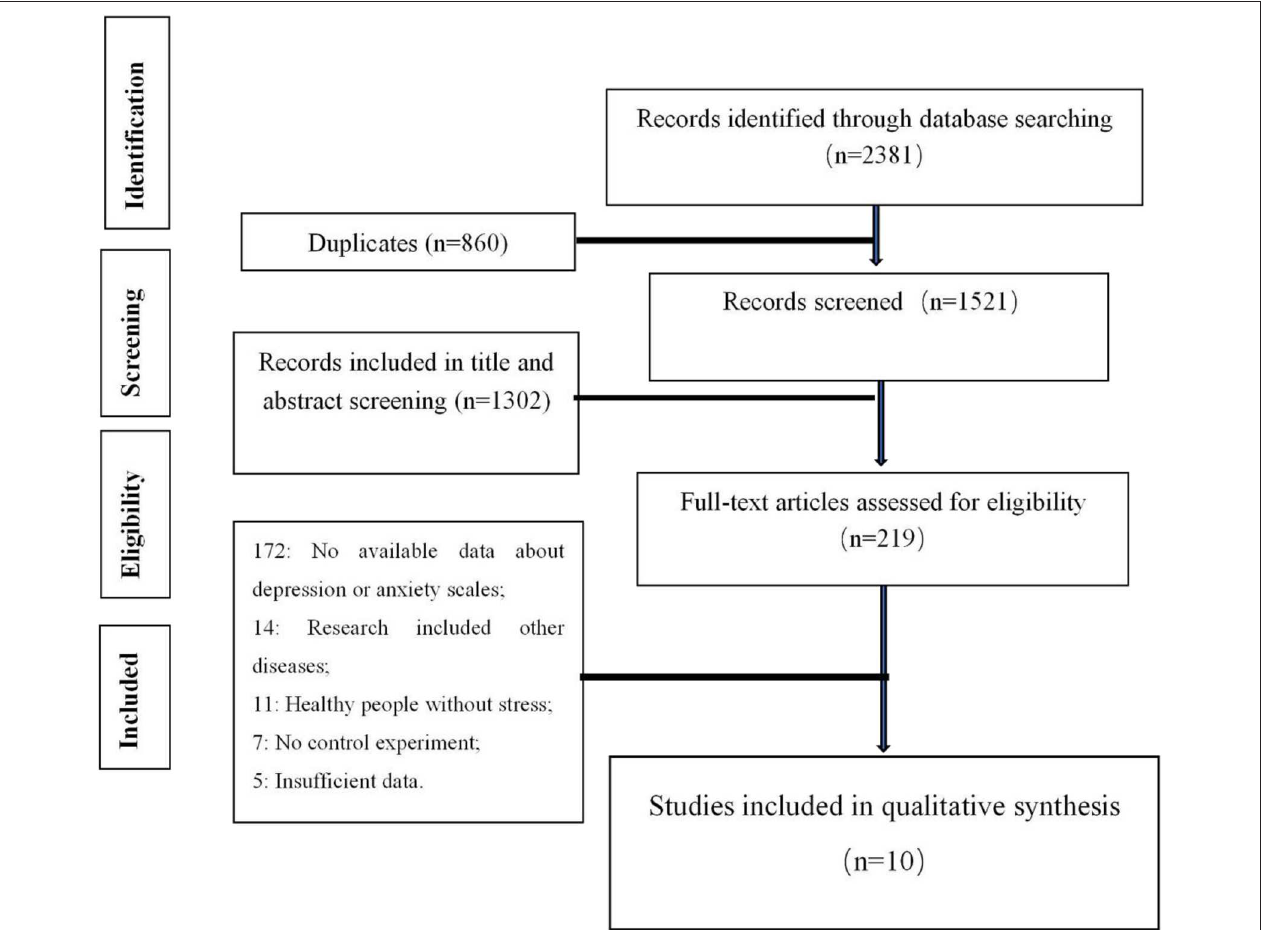
FIGURE 1 | PRISMA flowchart showing the study and selection process of the literature.